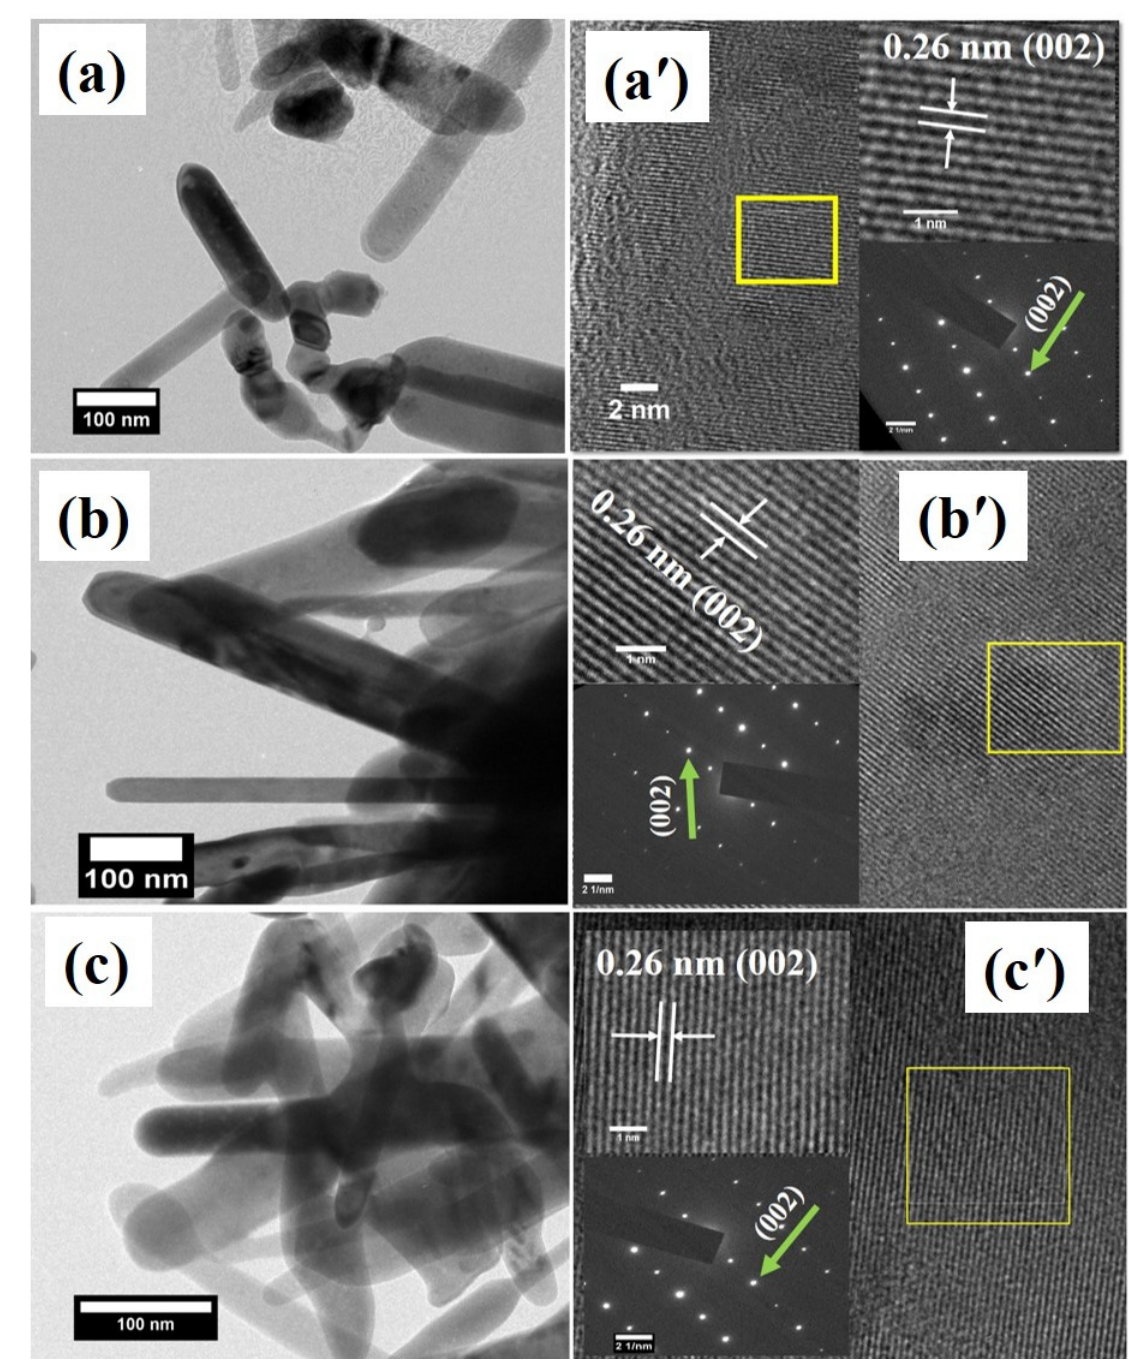
Figure 4. ( a – c ) TEM micrographs of Cu-doped ZnO nanostructures, ( a ′ – c ′ ) HR-TEM micrographs of Cu-doped ZnO nanostructures and insets represents the SAED pattern and zoom part of HR- TEM image.